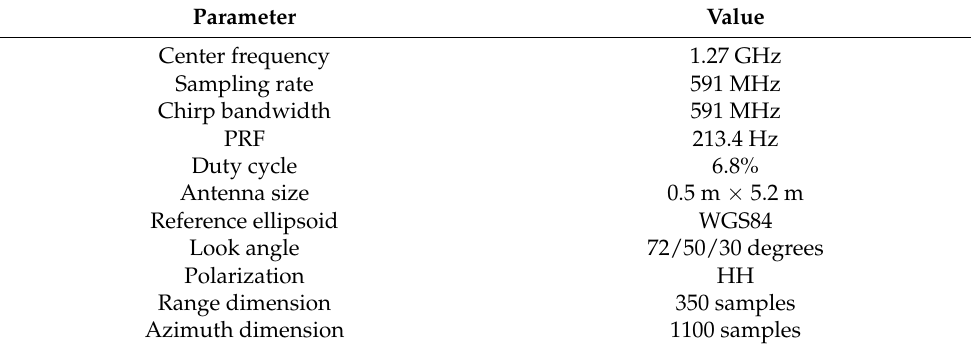
Table 3. The SAR simulation